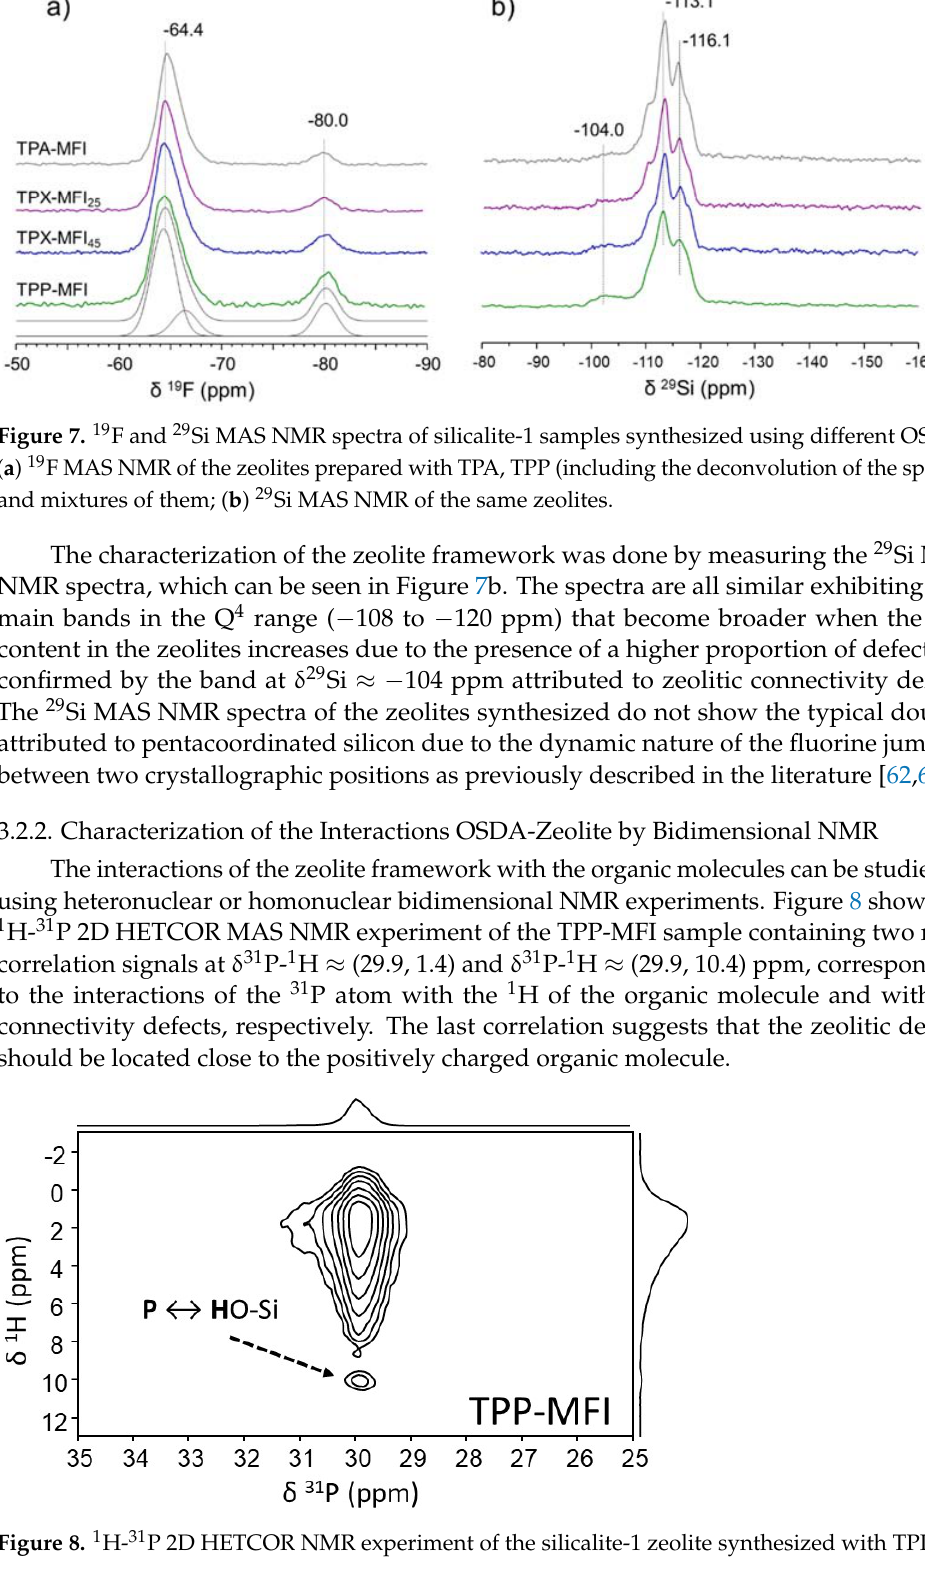
Figure 8. 1 H- 31 P 2D HETCOR NMR experiment of the silicalite-1 zeolite synthesized with